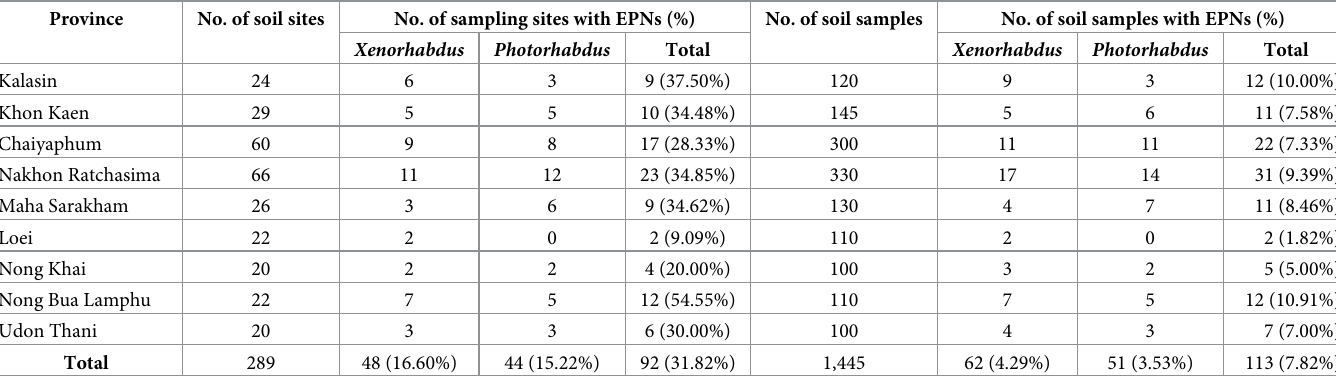
Table 1. Number of symbiotic bacteria isolated from soil samples from the Northeastern region of Thailand. Province No. of soil sites